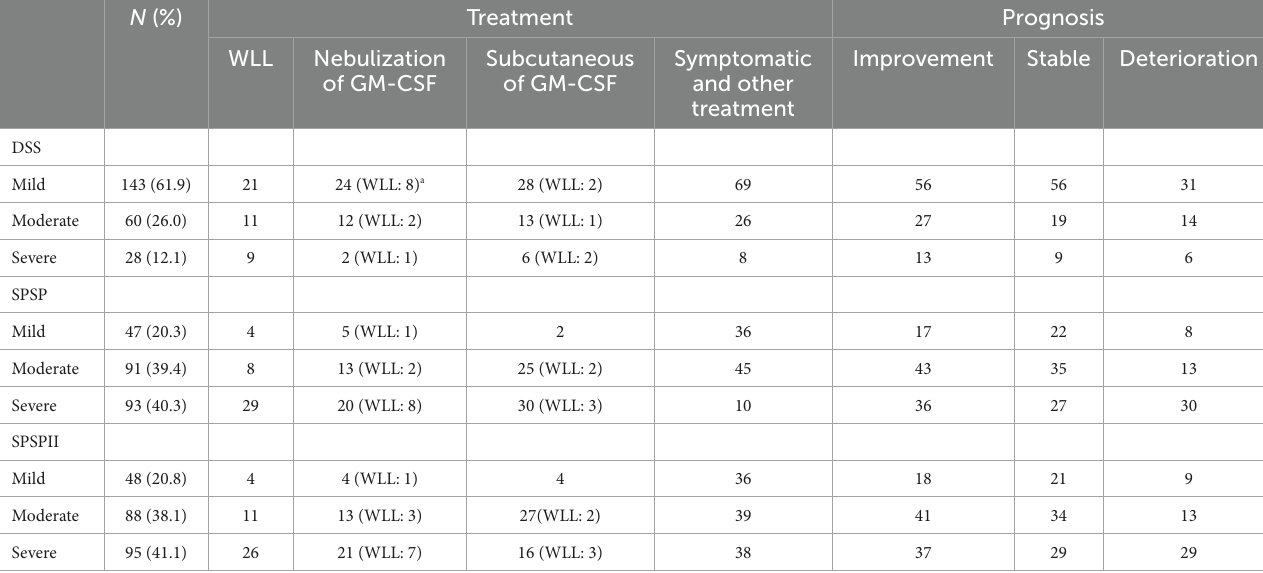
TABLE 3 Treatment and prognosis of patients in retrospective section.